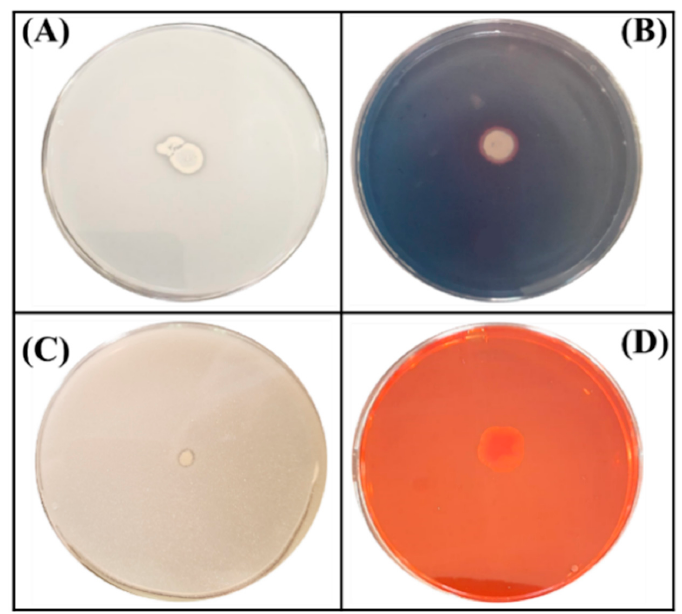
Figure 1. Schematic illustration of four tests performed on plates for the assessment of plant growth promoting traits of the ED1 isolate. ( A ) Phosphate solubilization, ( B ) Siderophores production, ( C ) Zinc oxide solubilization, ( D ) Cellulase production.